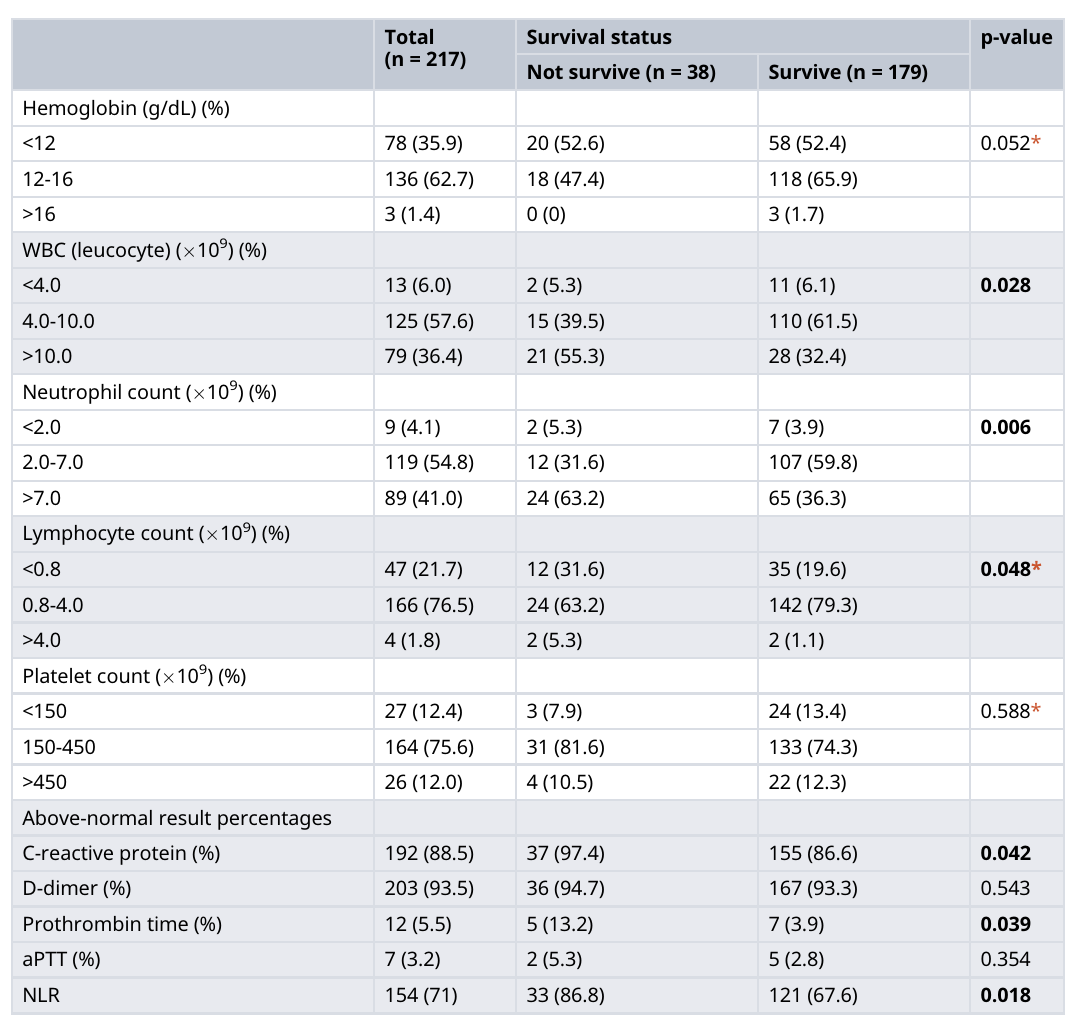
Table 2. Comparison of laboratory results in deceased and survived